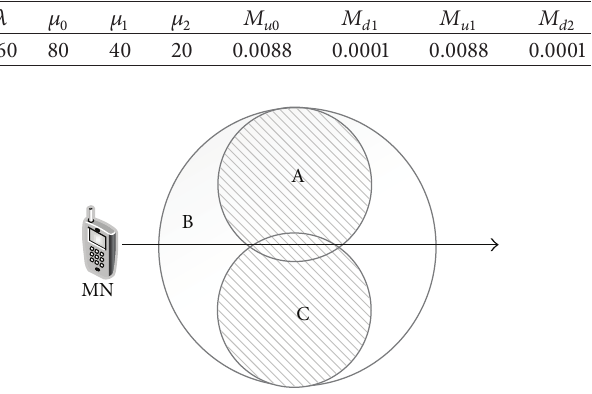
path while being connected to network B as shown in Figure 4. Along the path and within the coverage of network